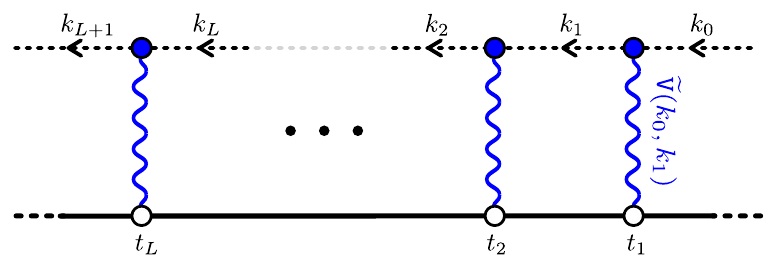
Figure 9 . Ladders of gluon exchange diagrams between the Wilson line and the fermion line. Here, the dashed lines are exact fermion propagators and the solid black line represents the Wilson line. These are the only diagrams that remains after resuming the loop corrections to the fermion propagator and the gluon exchange on the Wilson